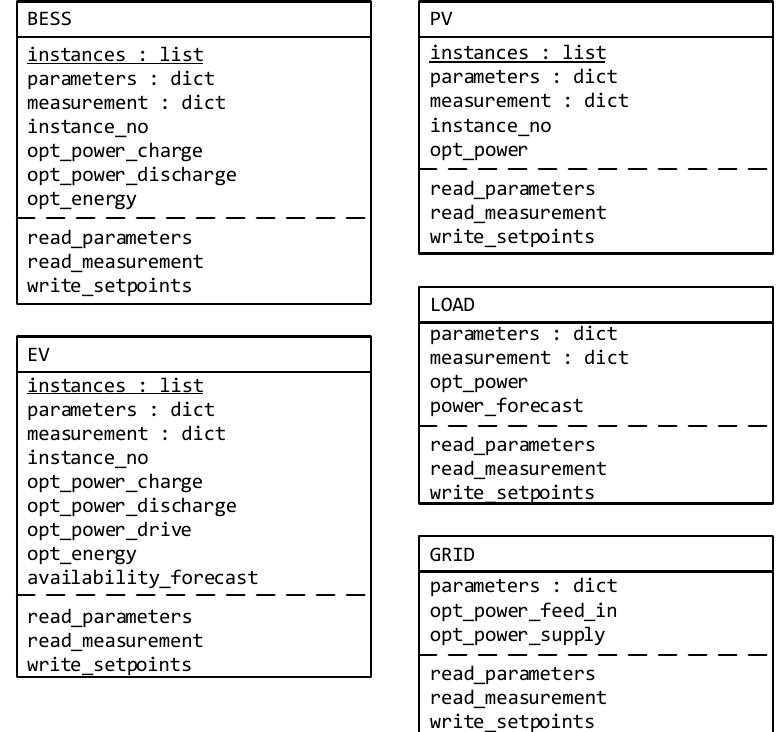
Figure 4. UML class diagram for the modular model composition in the EC.